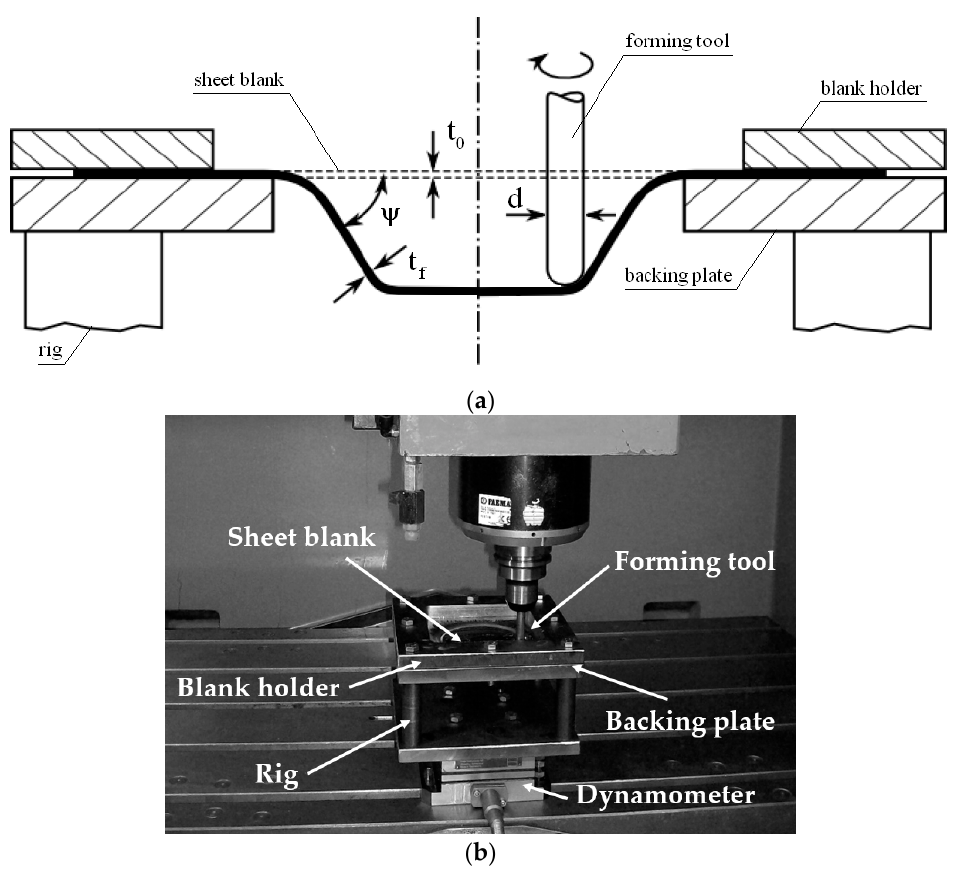
Figure 1. ( a ) Schematic representation of the SPIF process and ( b ) experimental setup utilized.